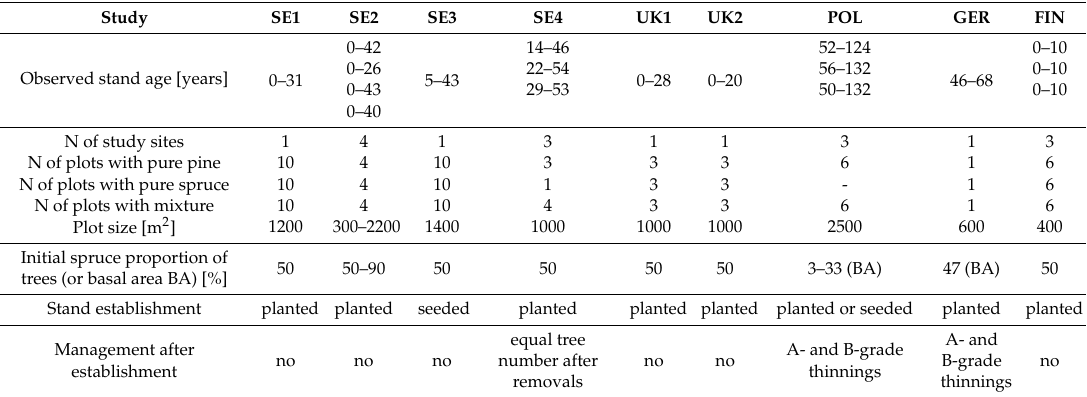
Table 2. Design of the nine studies of Norway spruce–Scots pine mixed forest included in this survey (A- and B-grade describe light thinning intensities in Germany and